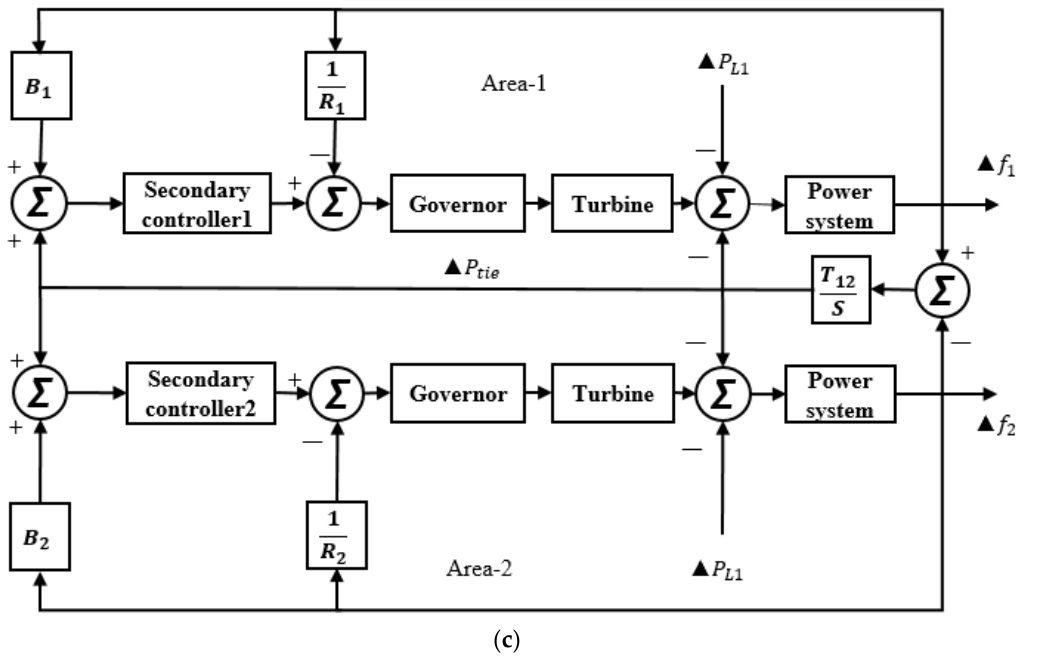
Figure 1. Circuit diagrams for the studied system ( a ) Circuit topology ( b ) LFC implemented a single area ( c ) Complete block diagram.